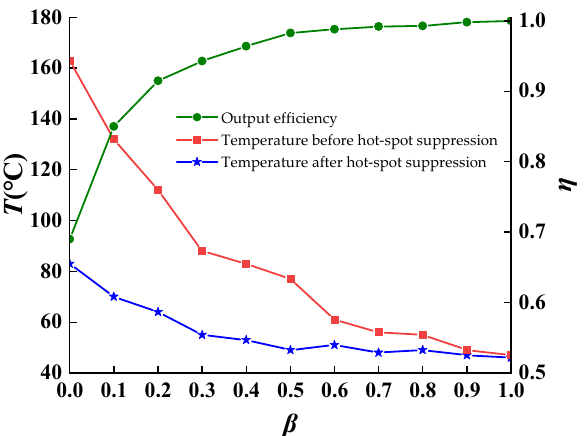
Figure 15. Experimental data of output efficiency and module temperature under different β .